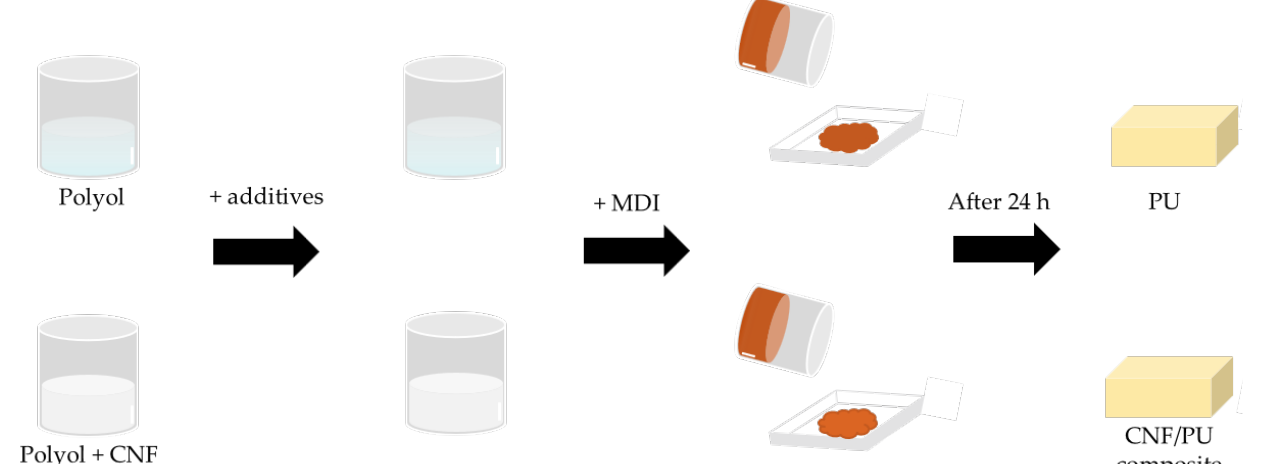
Figure 1. Simple schematic image of foam preparation. Table 1. The formulation of the PU foams. Components